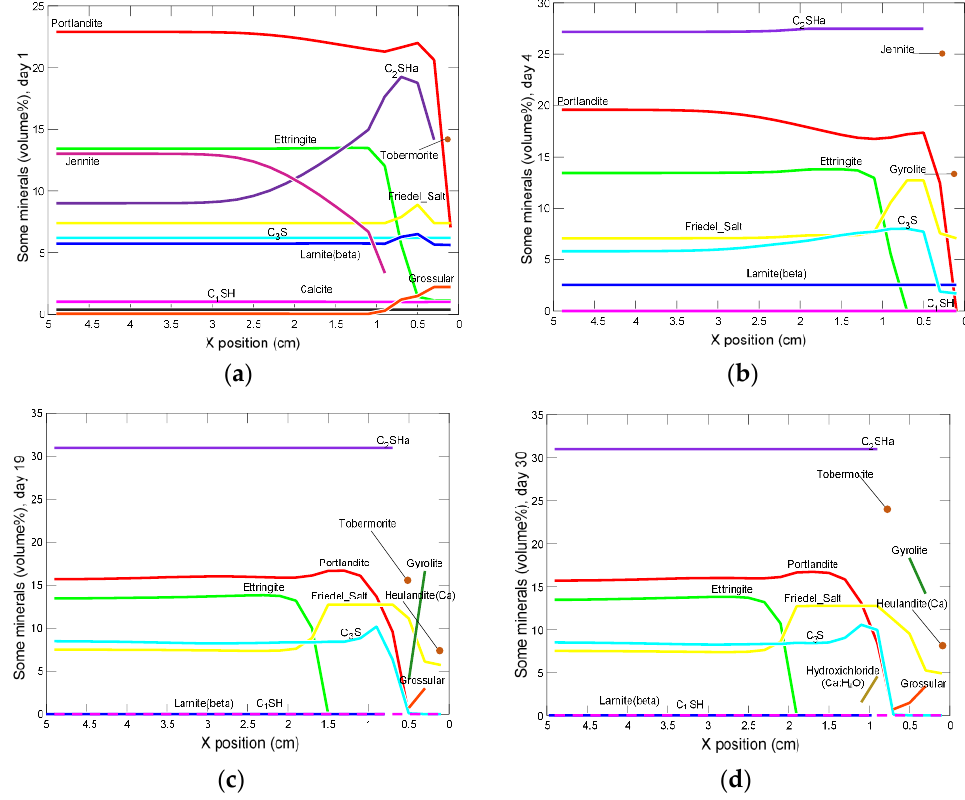
Figure 23. Profiles of changes in selected minerals in the domain of the model, in ( a ) 1, ( b ) 4, ( c ) 19, and ( d ) 30 days from the beginning of the experiment.